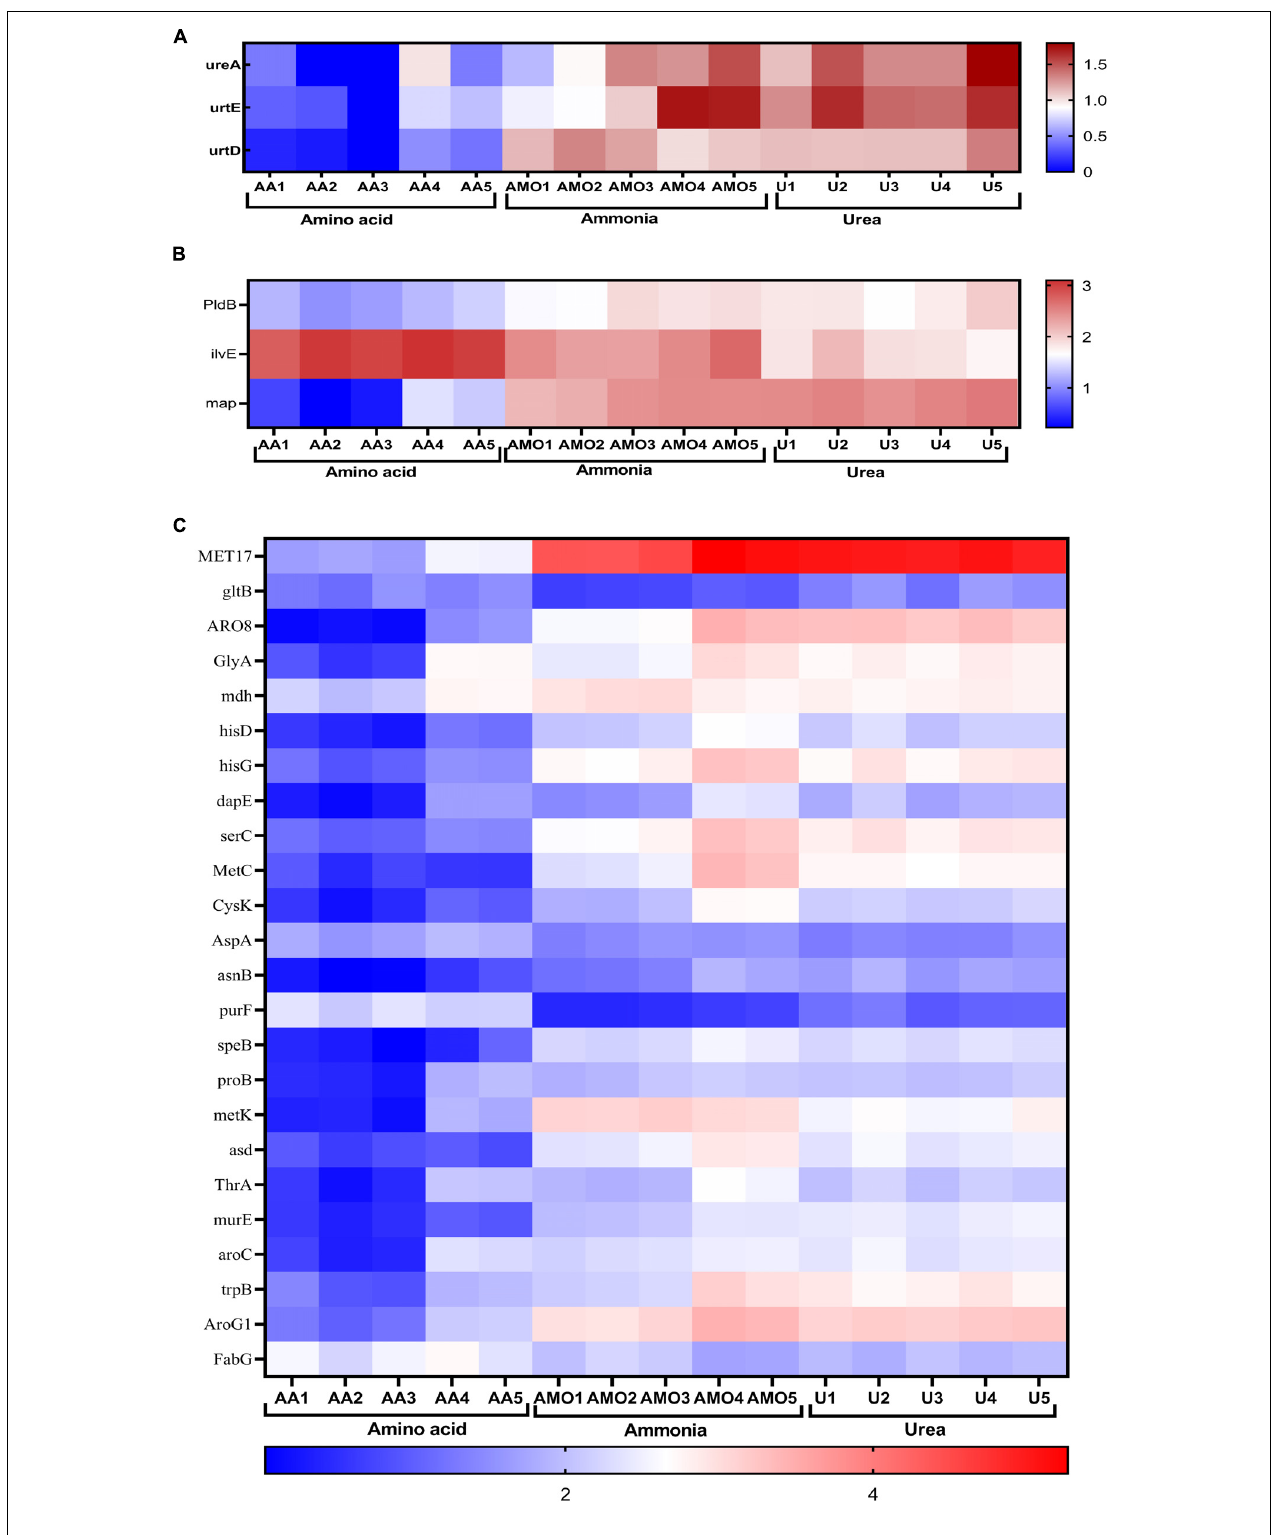
FIGURE 8 | Comparison of differentially expressed genes in cells grown in media containing amino acids, ammonia, or urea. Heat map displaying log-transformed normalized transcript abundances for a subset of genes involved in nitrogen metabolism. (A) Urease and urea transporter genes. (B) Genes involved in amino acid and peptide degradation. (C) Genes involved in ammonia assimilation and amino acid biosynthesis. Abbreviations AA1-5, AMO1-5, and U1-5 represent the five replications of amino acid, ammonia, and urea, respectively.